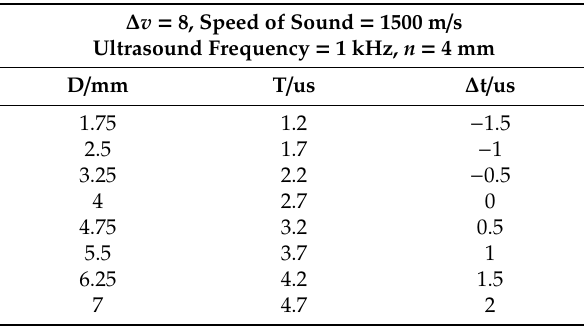
Table 5. Initial values when the surface